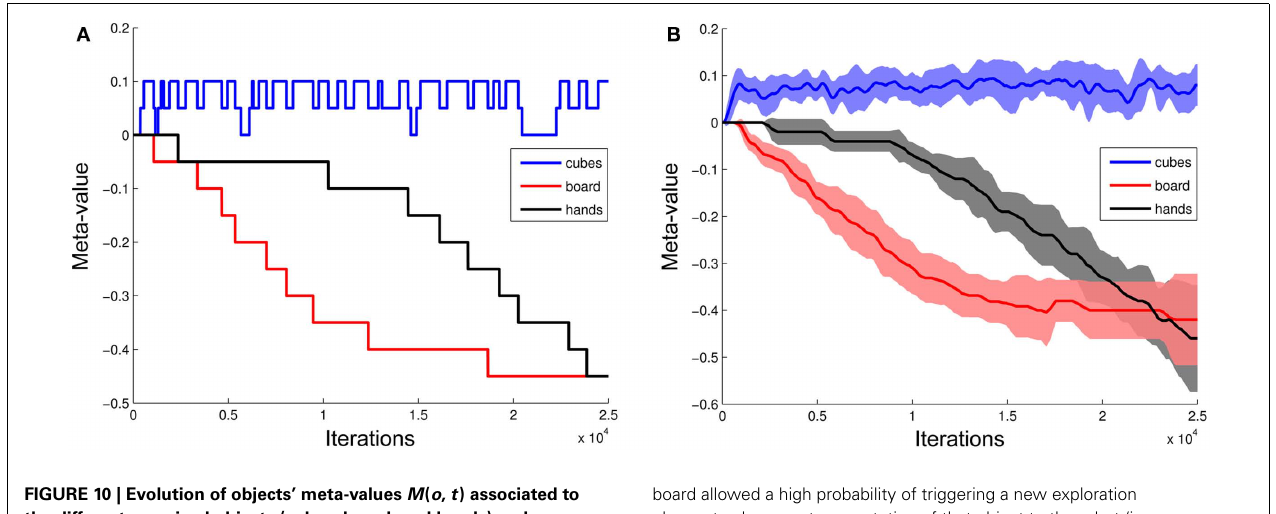
FIGURE 10 | Evolution of objects’ meta-values M ( o , t ) associated to the different perceived objects (cubes, board, and hands) and computed with Eq. 7 (A) during a sample session; (B) averaged over the eight experiments performed by the iCub robot ( N = 8). After about 10000 iterations of the model, the low meta-value of the